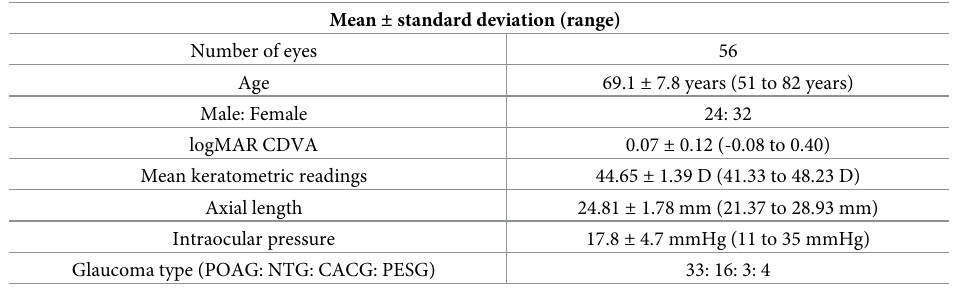
Table 1. The preoperative demographics of the study